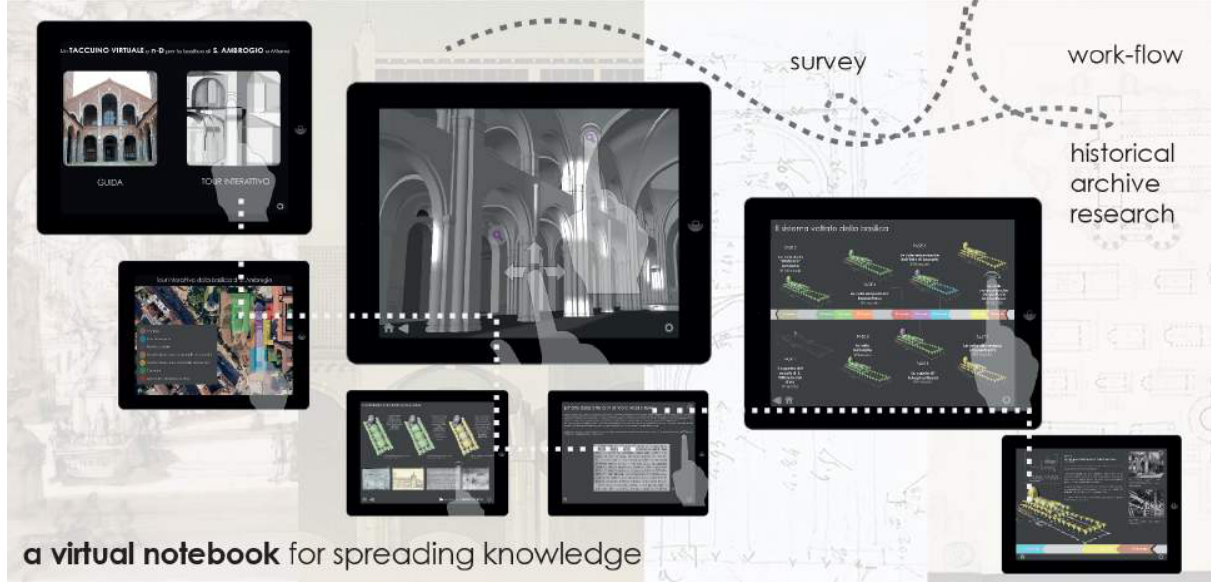
Figure 8. Interfaces of the virtual notebook of the